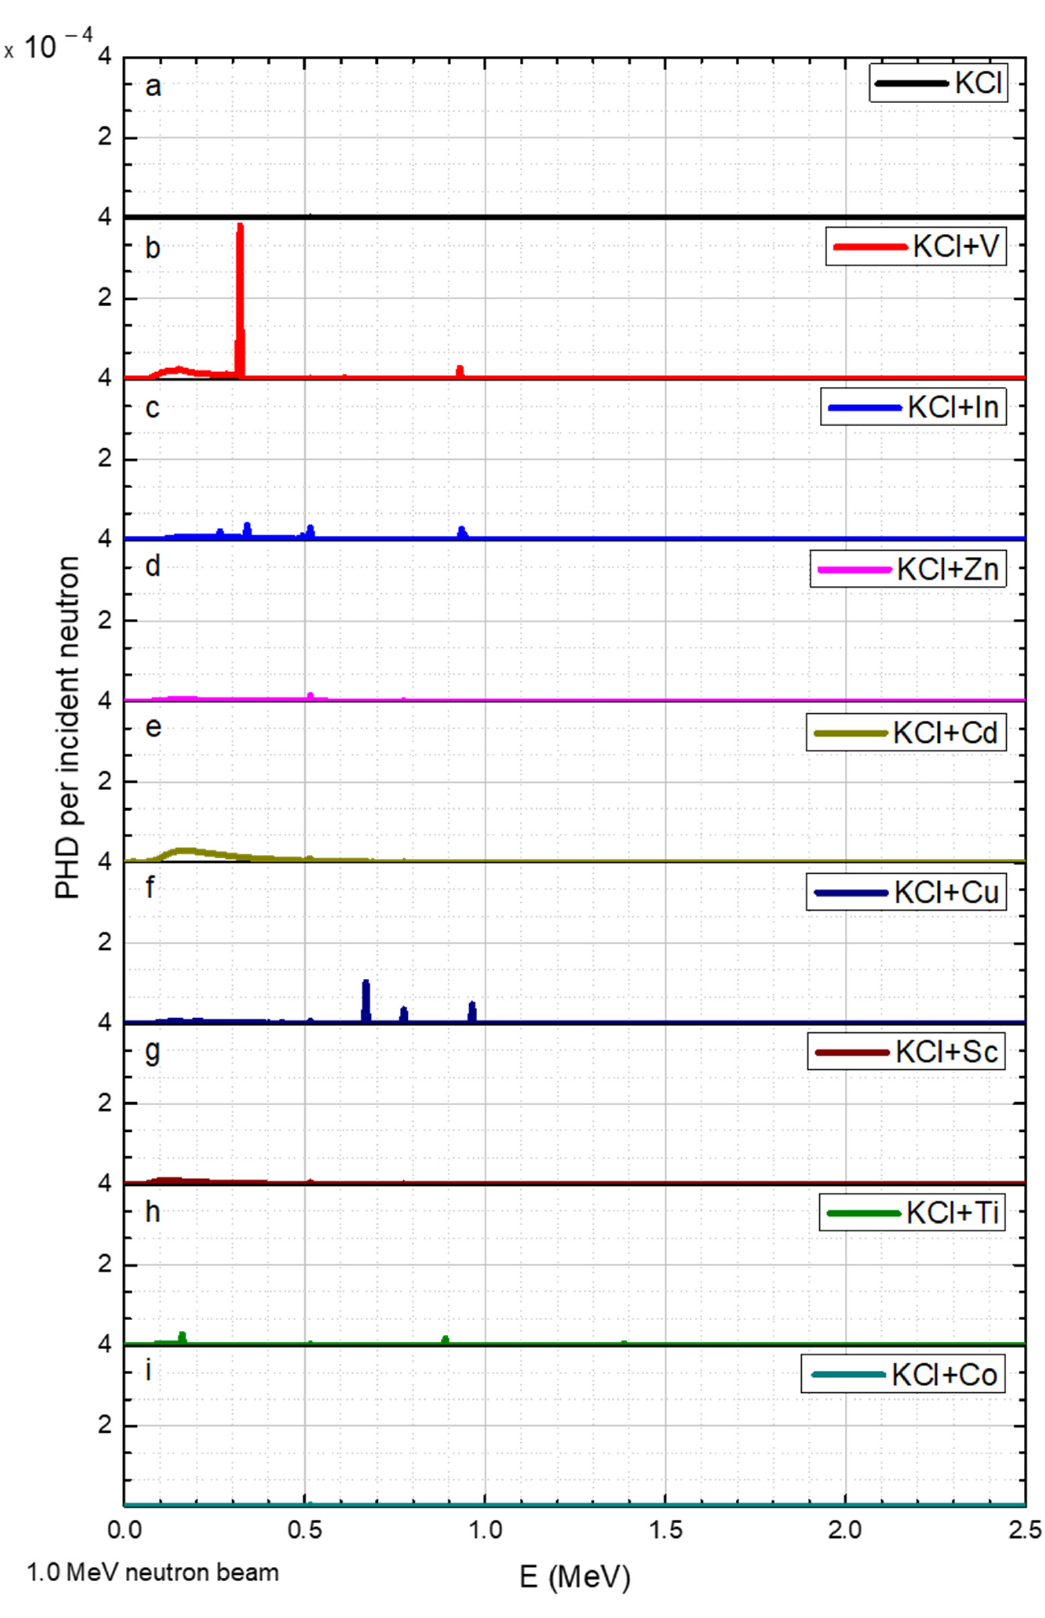
Figure 5. Neutron energy of 1.0 MeV PGNA results, where the y axis is the gamma pulse height distribution (PHD) per incident neutron obtained in the detector and the x axis is the gamma radiation energy. The data corresponds to a range of elements ( a – i ) added to the KCl. A 1.0 MeV neutron flux throughout the KCl converter had a minor influence, evident